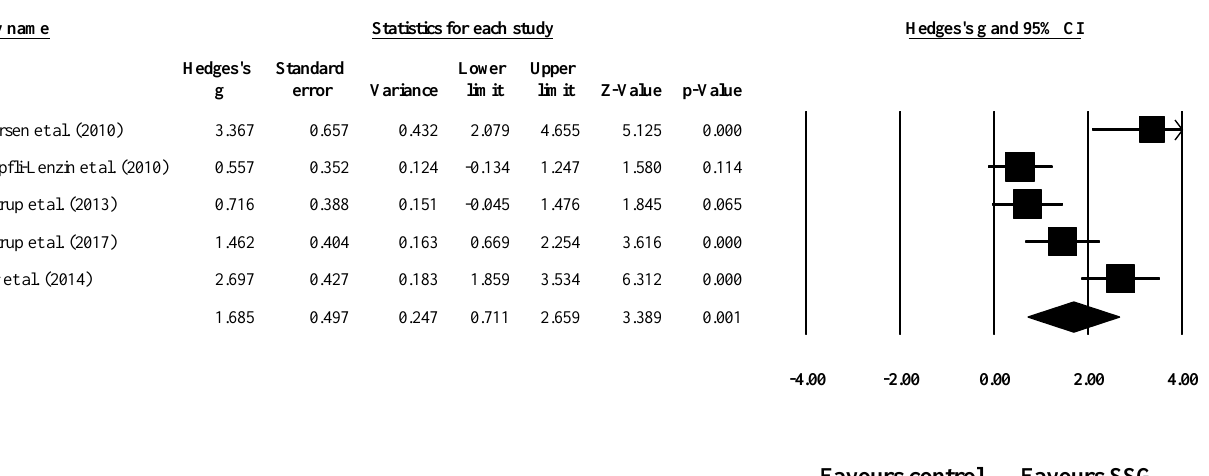
Figure 2. Forest plot of the changes in systolic blood pressure after participating in small-sided games (SSGs) compared to the control condition. Values shown are effect sizes (Hedges’s g) with 95% confidence intervals (CI). The size of the plotted squares reflects the statistical weight of each study. Table 6. Summary of the included studies and results of diastolic blood pressure before and after intervention. Before After After–Before Study Group N Mean ± SD Mean ± SD ( ∆